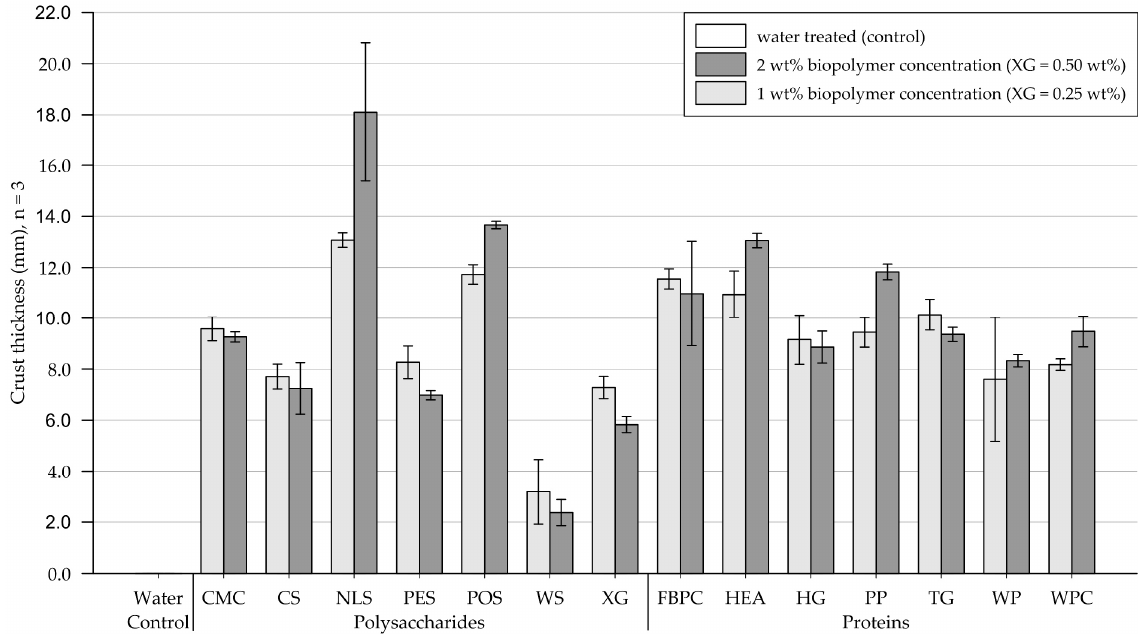
Figure 12. Mean thickness of crust formed on fine-grained silica sand samples. Biopolymers are grouped into polysaccharides and proteins with water as control. Tests were performed with six replicas ( n = 3), with error bars indicating the standard deviation (SD). Note. The exact values of experimental results are appended in Table A5 .